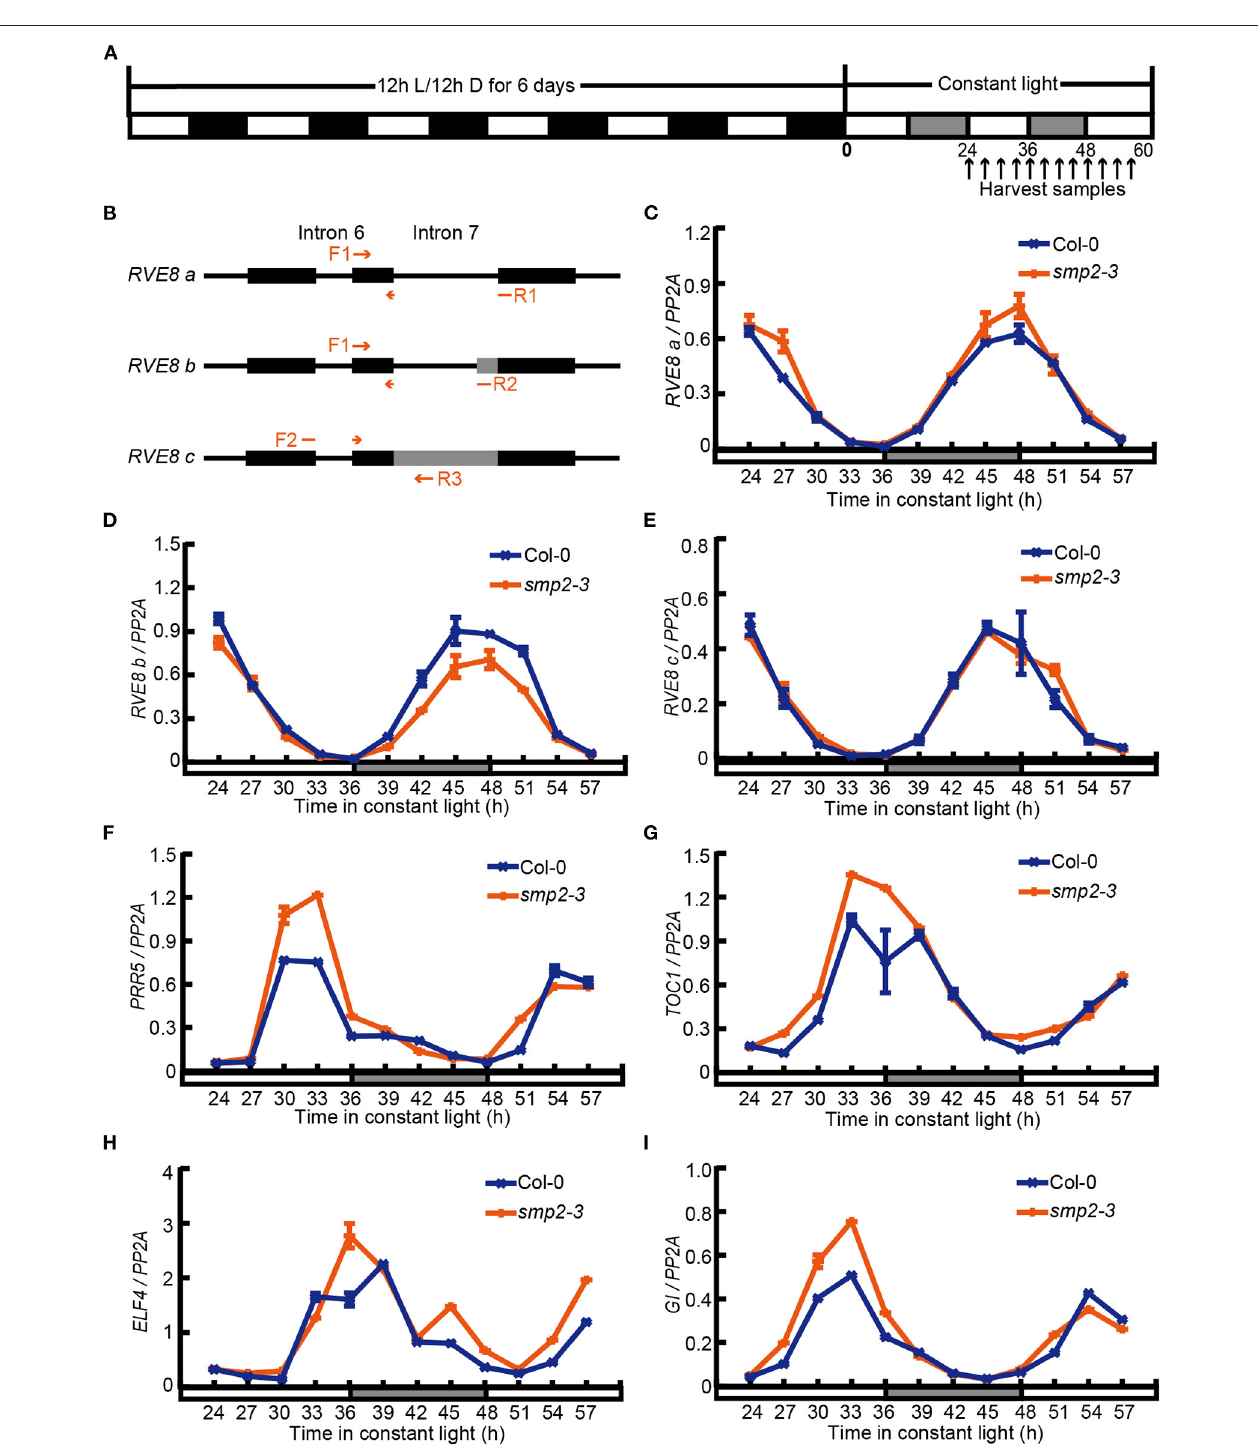
FIGURE 4 | SMP2 regulates A3’SS in RVE8 and inhibits the expression of RVE8-activated genes. (A) Simplified diagram of the diurnal entrainment of seedlings. Plants were entrained in the diurnal cycles (12h light/12h dark) for 6 days and then transferred to continuous white light (145 µ mol · m − 2 · s − 1 ). Seedlings were harvested at the indicated time points. (B) The schematic graph of splice variants of RVE8 in intron 7. Red arrows indicated primers used to amplify specific RVE8 transcript isoforms. Exons were depicted as black rectangles; introns were depicted as horizontal lines; alternative splicing regions were depicted as gray rectangles. (C–E) The relative abundance of three RVE8 isoforms in Col-0 and smp2-3. Total RNA was extracted from Col-0 and smp2-3 seedlings treated as described in (A) . PP2A was used as the internal control. (F–I) The relative expressions of PRR5 , TOC1 , ELF4 , and GI in Col-0 and smp2-3 . Error bars represent SD, n = 3. All of these experiments were performed three times with similar